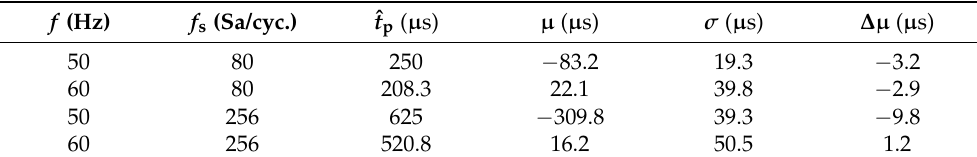
Table 1. Gaussian Fit Results for the QTP Method.